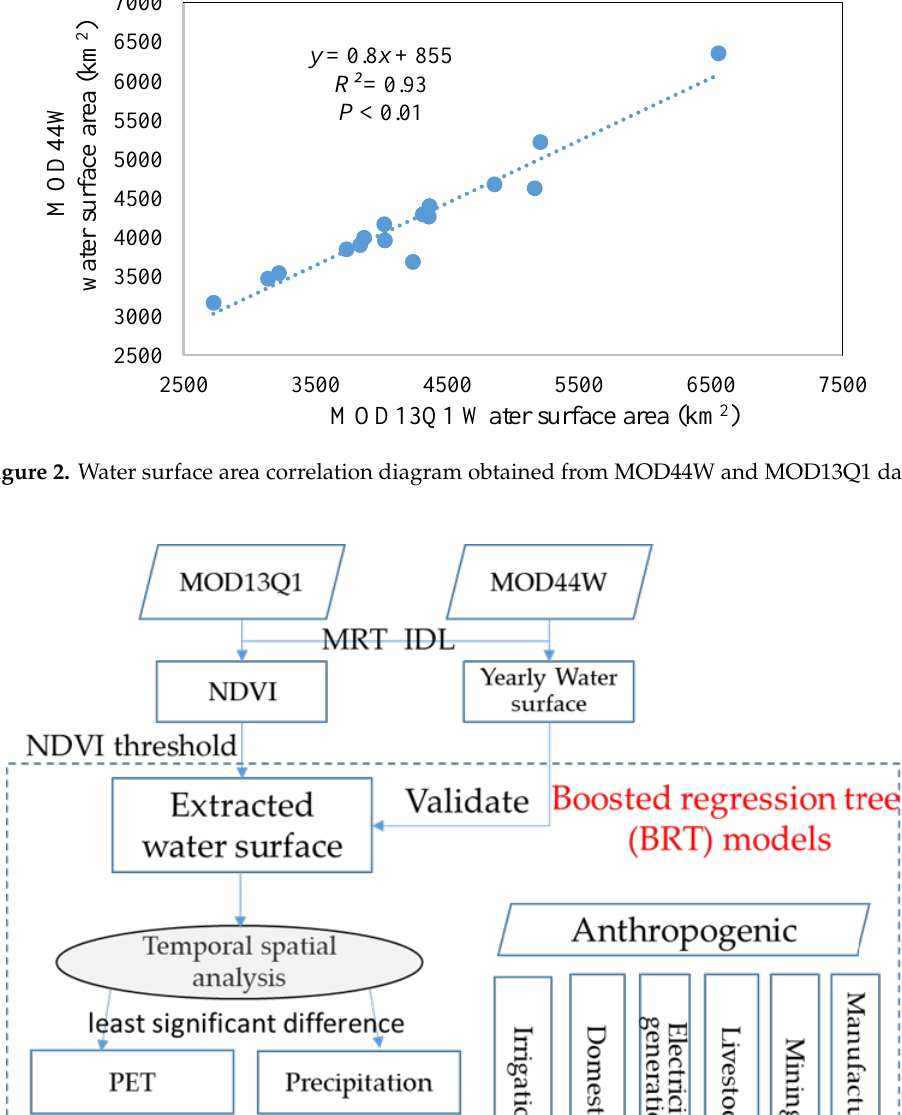
y = 0.8 x + 855 R² = 0.93 P < 0.01